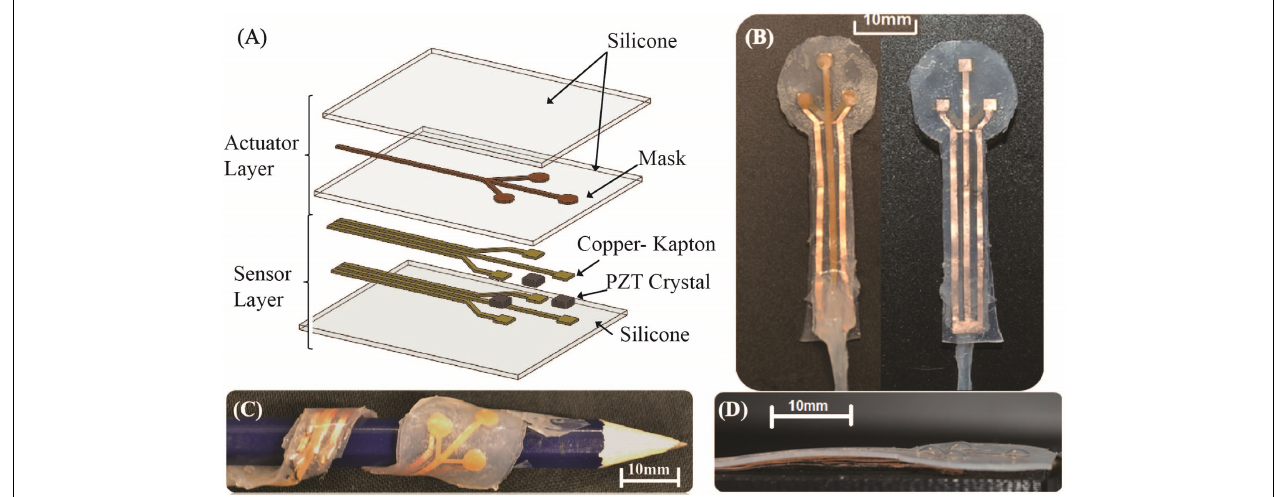
FIGURE 1 | The construction of the SPA skin with integrated PZT sensors . The schematic of the multi-layer construction of SPA skin (A) . The prototype shows three sensor pixels for independent measurement (B) . Functional SPA skin prototype on a curvy surface (C) . The three 4mm diameter vibratory actuators generate 0.8–1mm vertical amplitude range (D) .